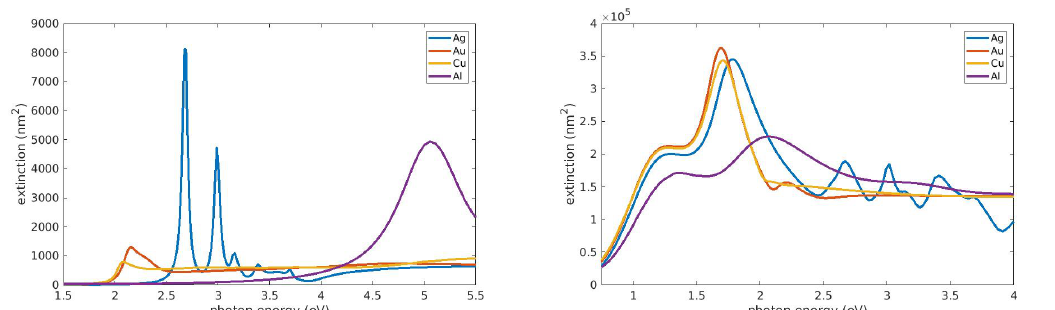
Figure 5. Extinction efficiency for Ag, Au, Al and Cu nanocube with side length L = 20 (left) and 200 (right) nm embedded in water ( (cid:101) h =